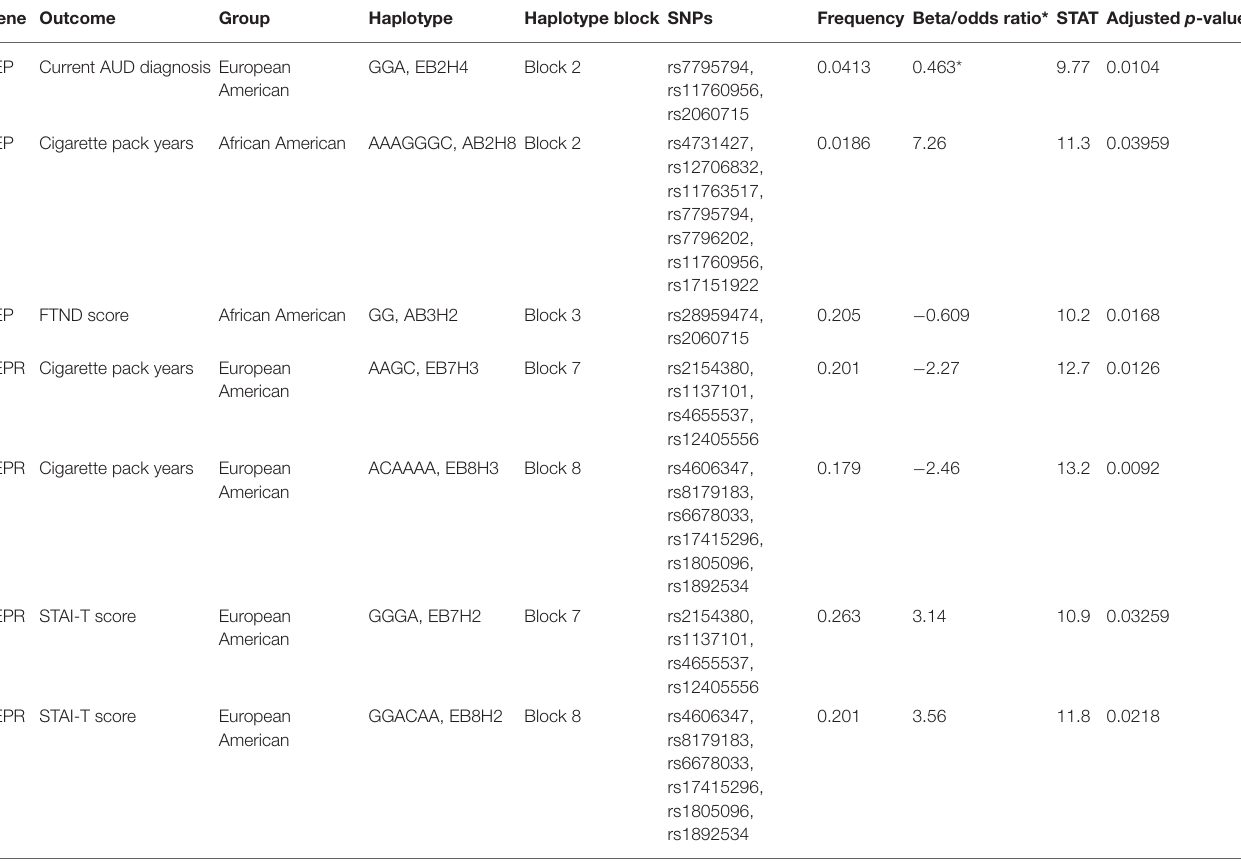
TABLE 2 | Significant results of haplotype association